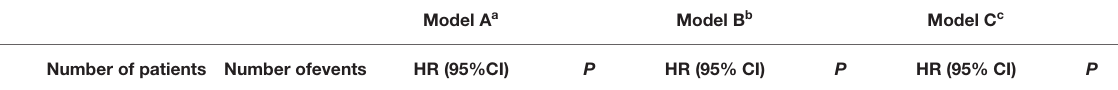
TABLE 4 | Association of every 10% insurance self-paying rate increase with lung cancer-specific death and all-cause